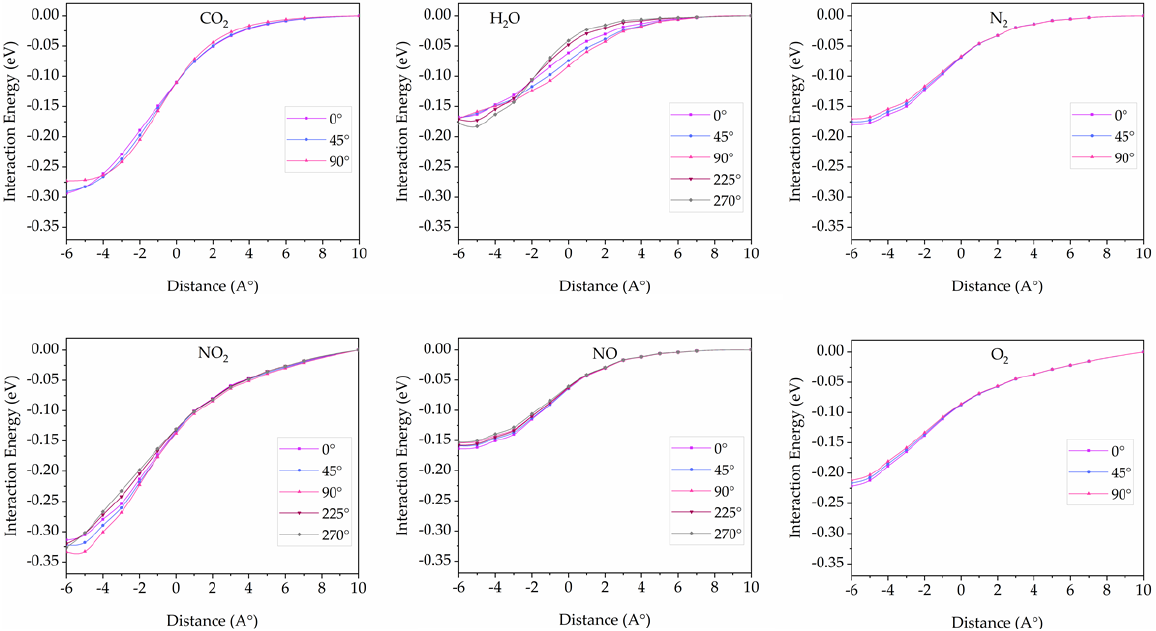
Figure 12. Interaction energies between 3D pillared SiC (6,6) nanostructures and gas molecules with various orientations as a function of distance.